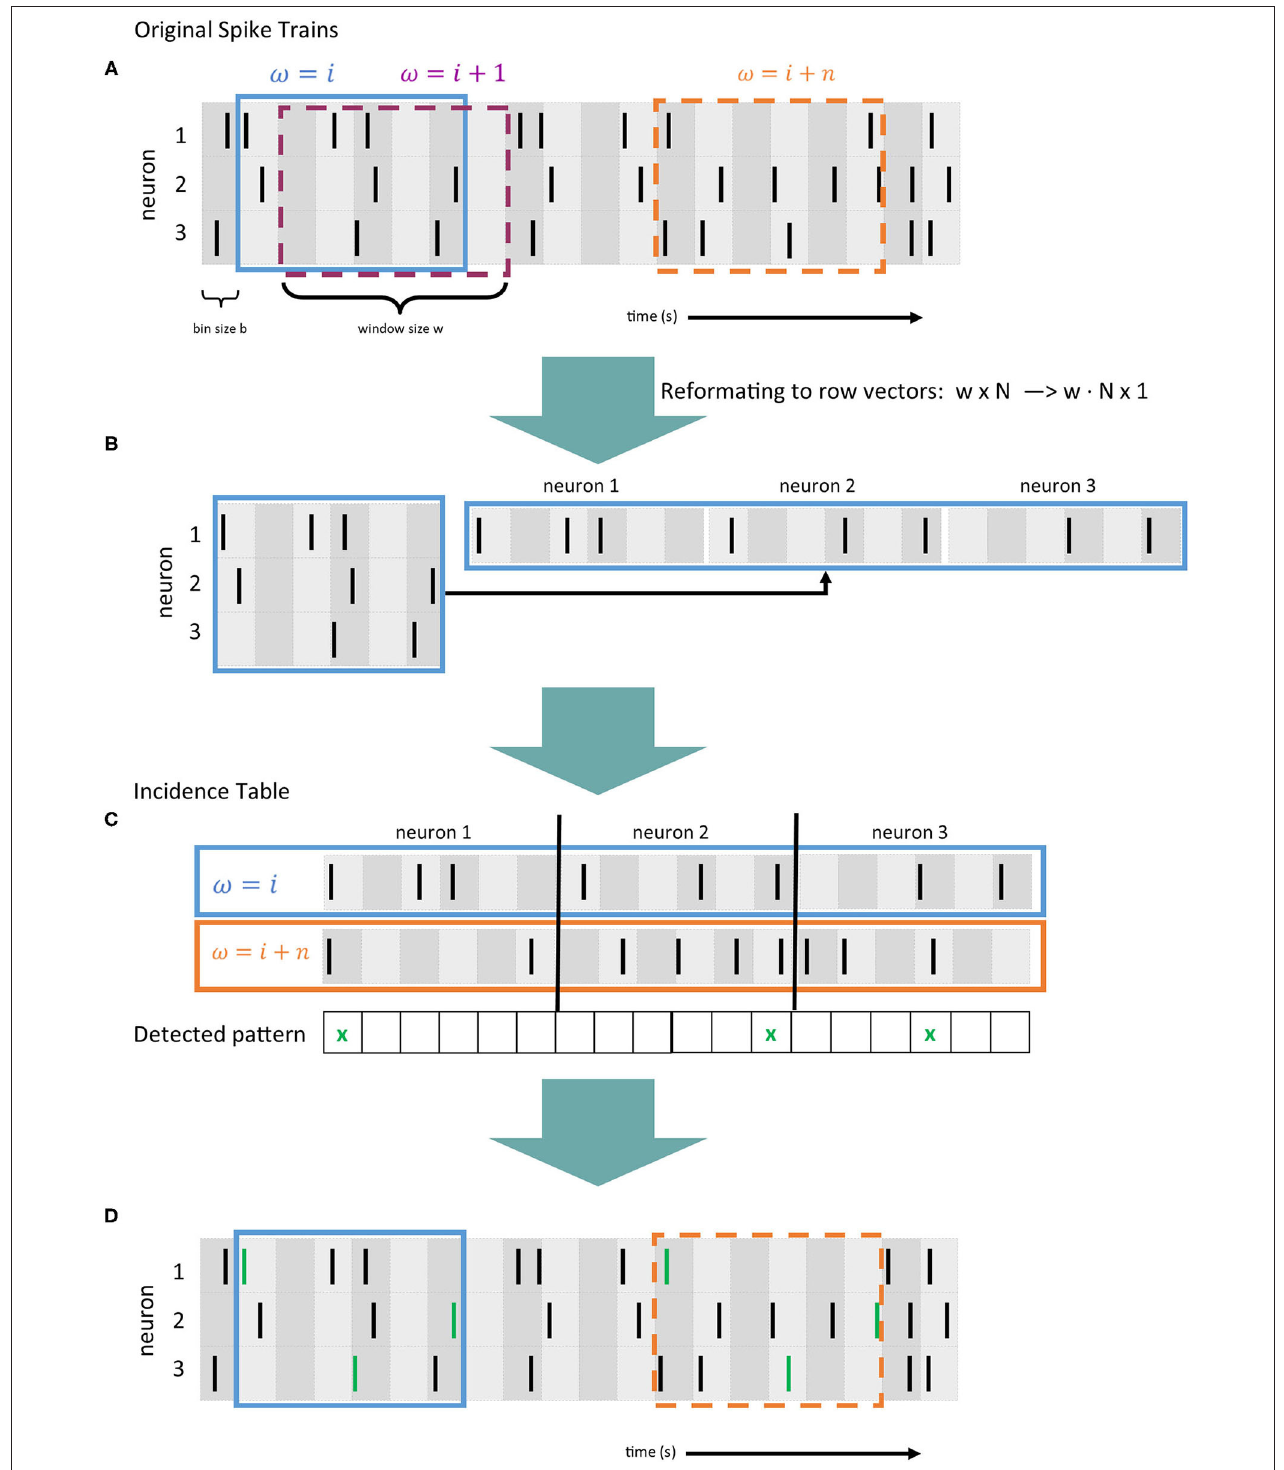
FIGURE 2 | Data preprocessing and evaluation flow of SPADE [based on Stella et al. (2019)]. (A) Example of 4 spike trains recorded in parallel, where each black line represents a spike. Time is divided into bins (gray vertical areas) of length b . A sliding window of size w is shifted bin by bin over the data (in blue, purple and orange). (B) The window matrix representation is converted to a row vector. (C) Simplified visualization of the pattern mining process (also called incidence table), where spikes occurring in the same bin in two window positions ( ω = i and ω = i + n ) are detected. Coincident spikes across the two windows are indicated with a green cross. (D) Representation of the original spike trains as in panel A, where the spike pattern is detected and indicated with green lines.